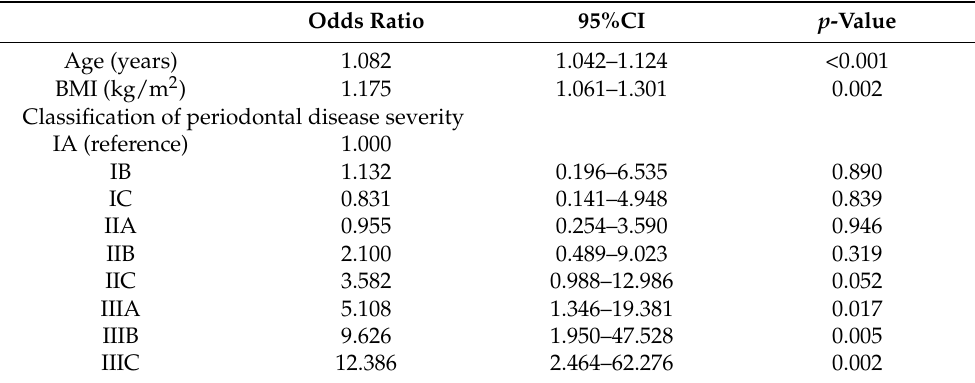
Table 2. Factors associated with type 2 diabetes and the classification of periodontal disease severity— multivariate logistic regression analysis with forward selection.